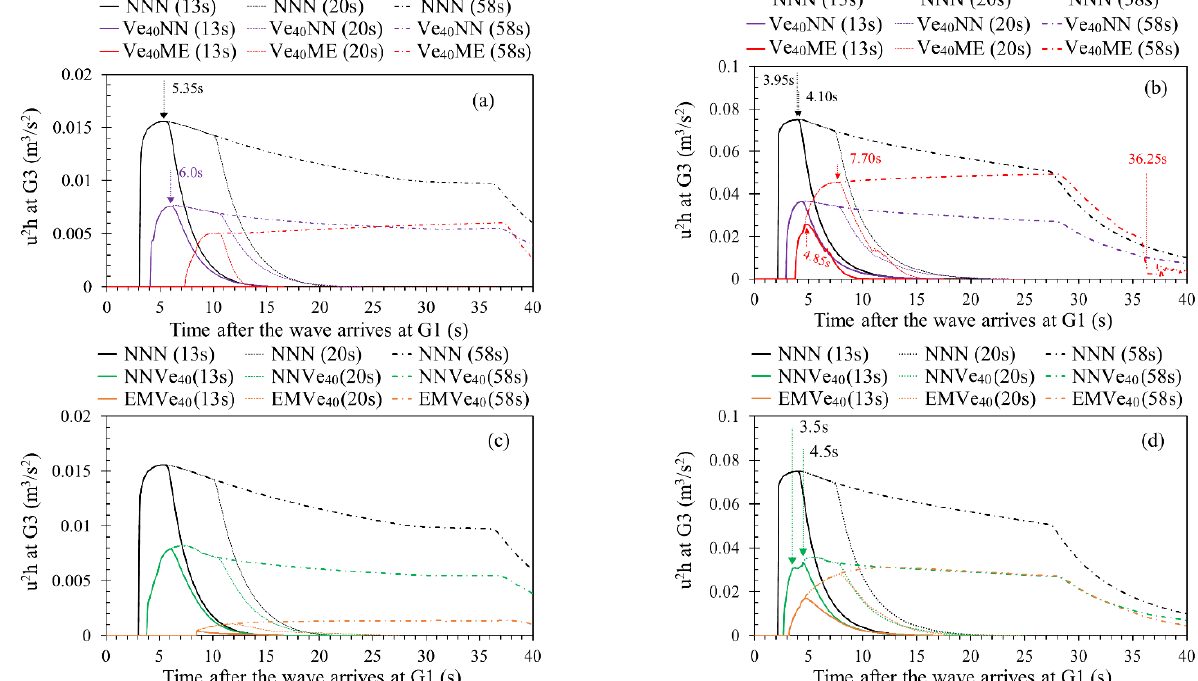
Figure 11. Time series of fluid force index (u 2 h) at G3. ( a ) H D = 0.73: seaward vegetation type, ( b ) H D = 1.42: seaward vegetation type, ( c ) H D = 0.73: landward vegetation type, ( d ) H D = 1.42: landward vegetation type.